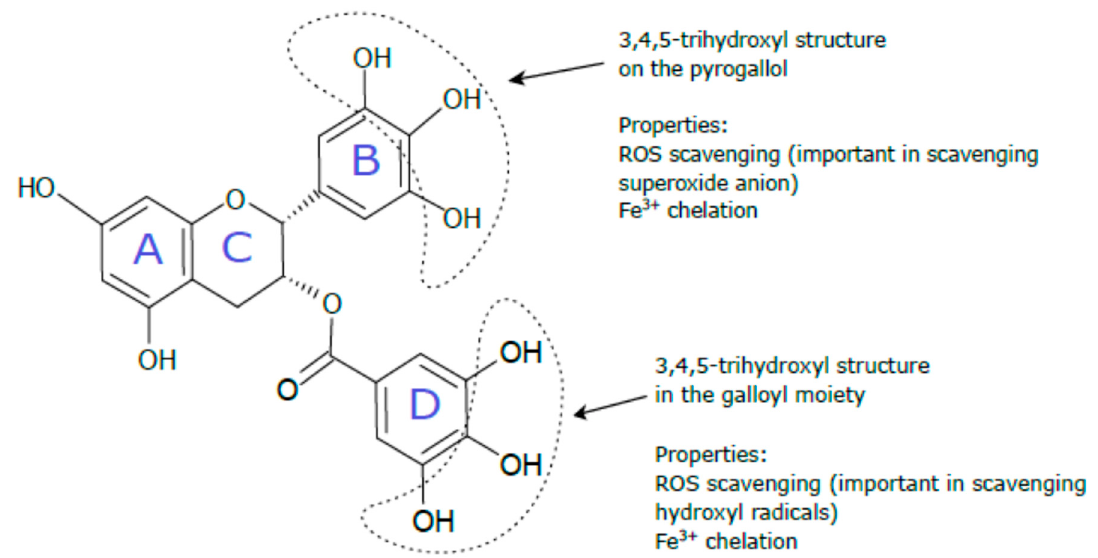
Figure 1. Epigallocatechin gallate (EGCG) structure. EGCG is composed of four rings designated as A, B, C, and D. The A and C rings form a benzopyran ring system, which is connected with the pyrogallol (the B ring) and gallate (the D ring) moiety at the C-2 and C-3 positions, respectively [45]. The role of the functional groups in the antioxidant properties of EGCG was described on the basis of other studies [49–51].